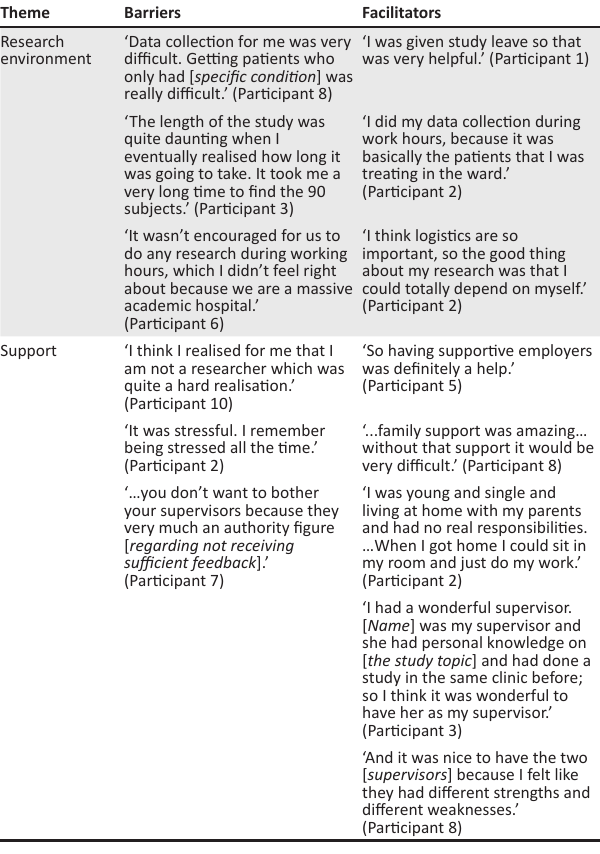
TABLE 3: Participant quotes regarding perceived barriers and facilitators within the themes. Theme Barriers